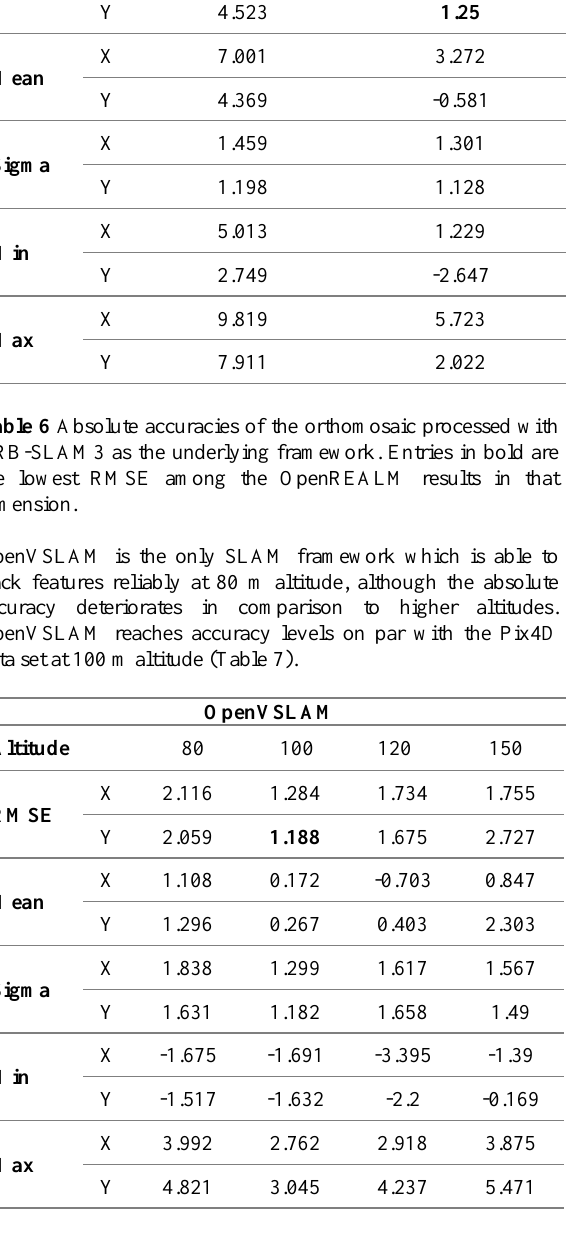
Table 5 Absolute accuracies of the reference orthomosaic processed in Pix4D without ground control